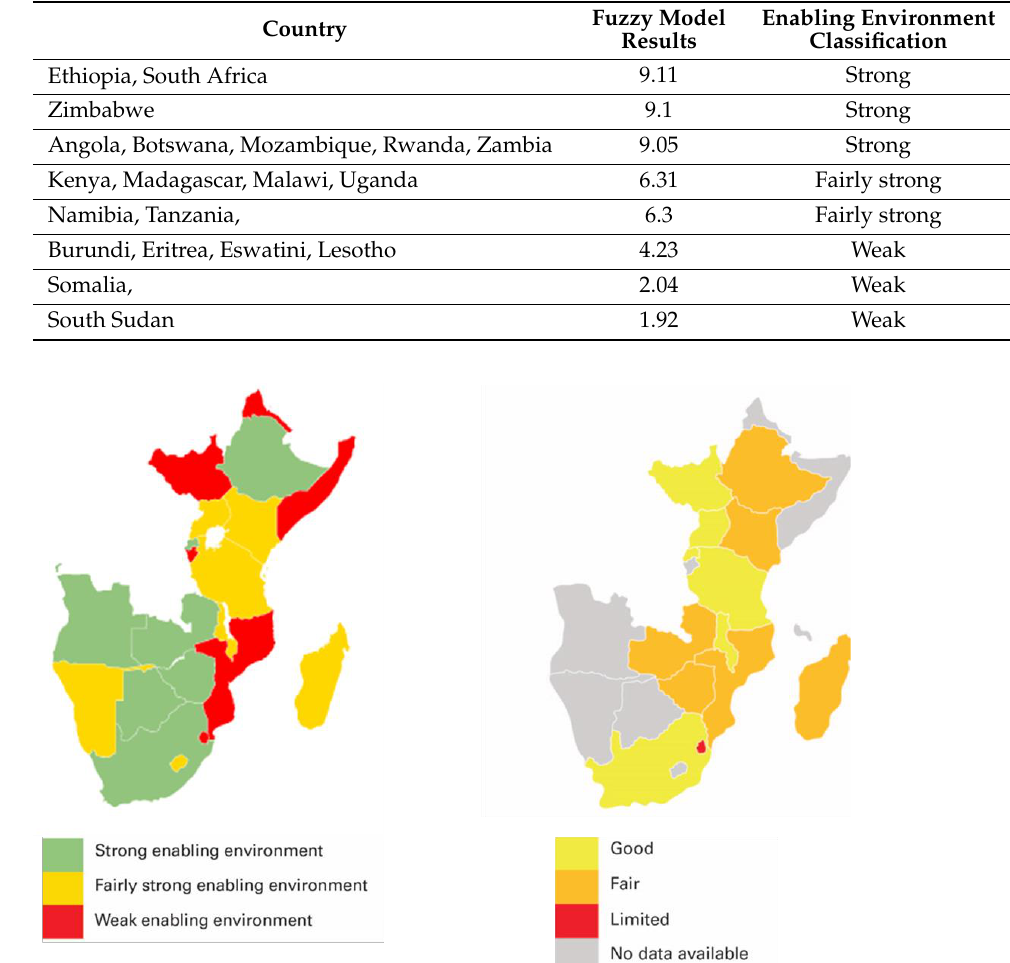
Figure 8. ESAR countries’ enabling environment and data for monitoring SDG 6 fuzzy logic analysis